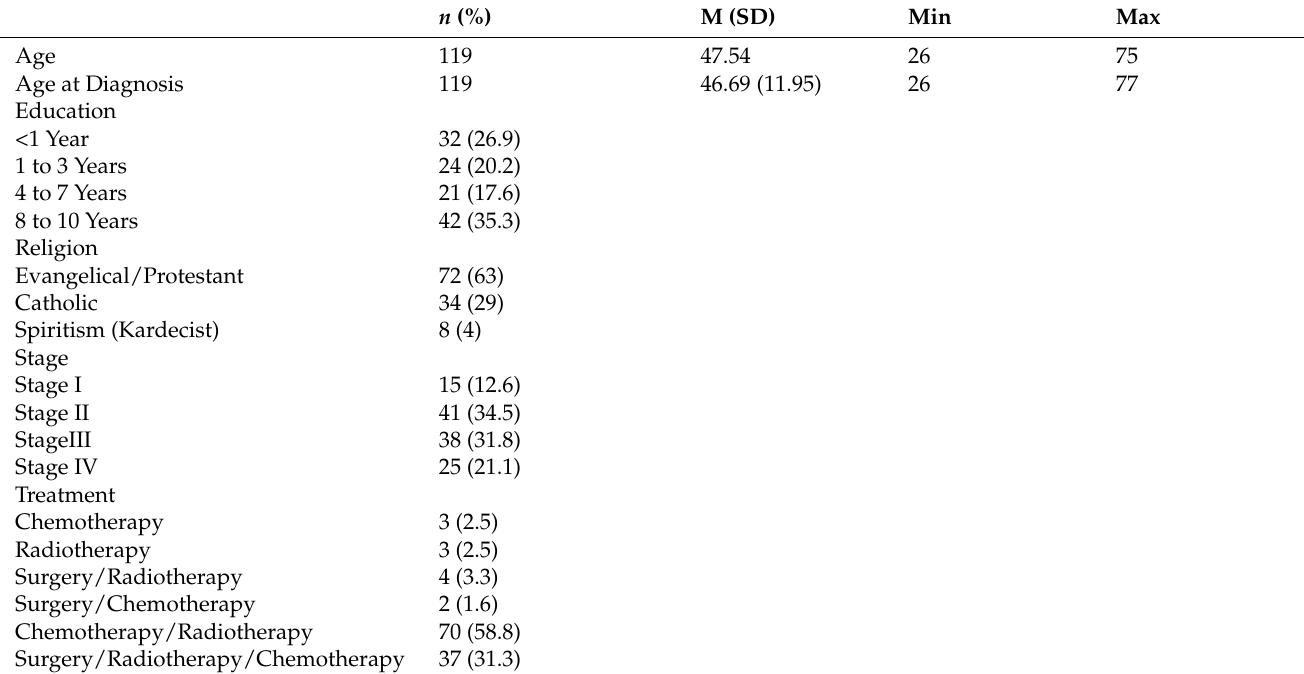
Table 1. Sociodemographic and clinical characteristics of the sample